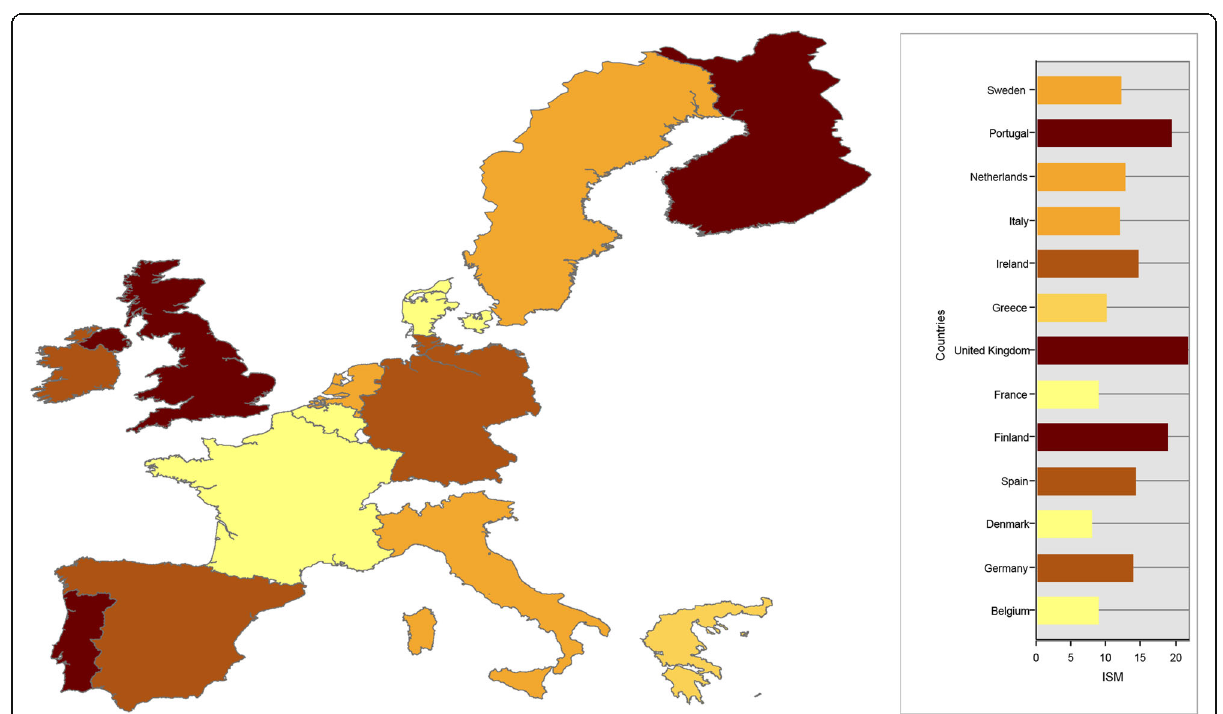
Fig. 11 The weighting of ISM Code deficiencies as a result of AHP